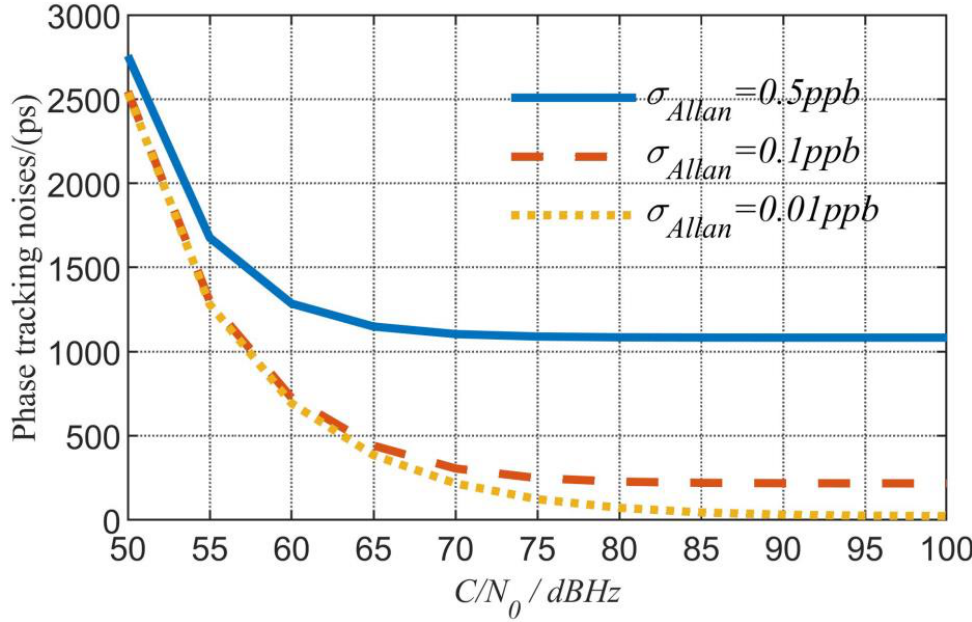
Figure 6. Simulation results of the phase tracking error.